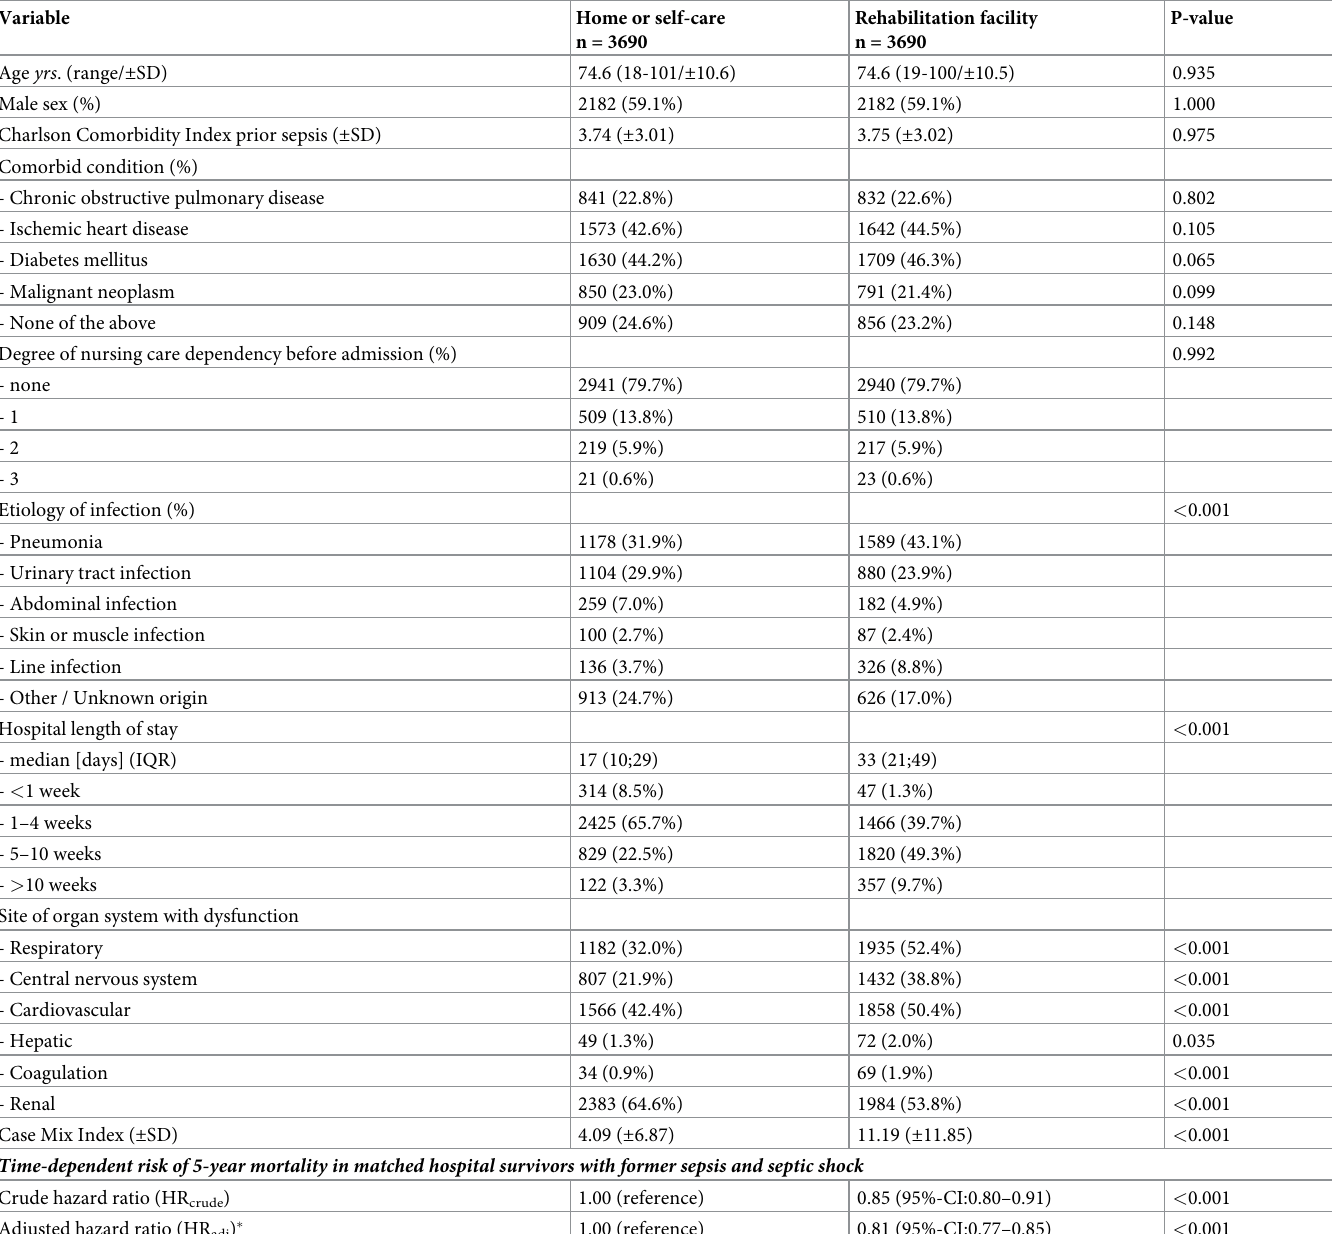
Table 2. Characteristics of matched patients with sepsis and septic shock stratified according discharge destination after index